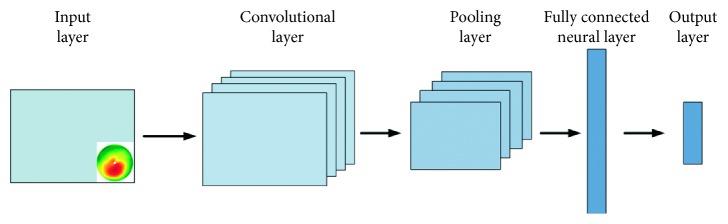
Structure of a CNN.